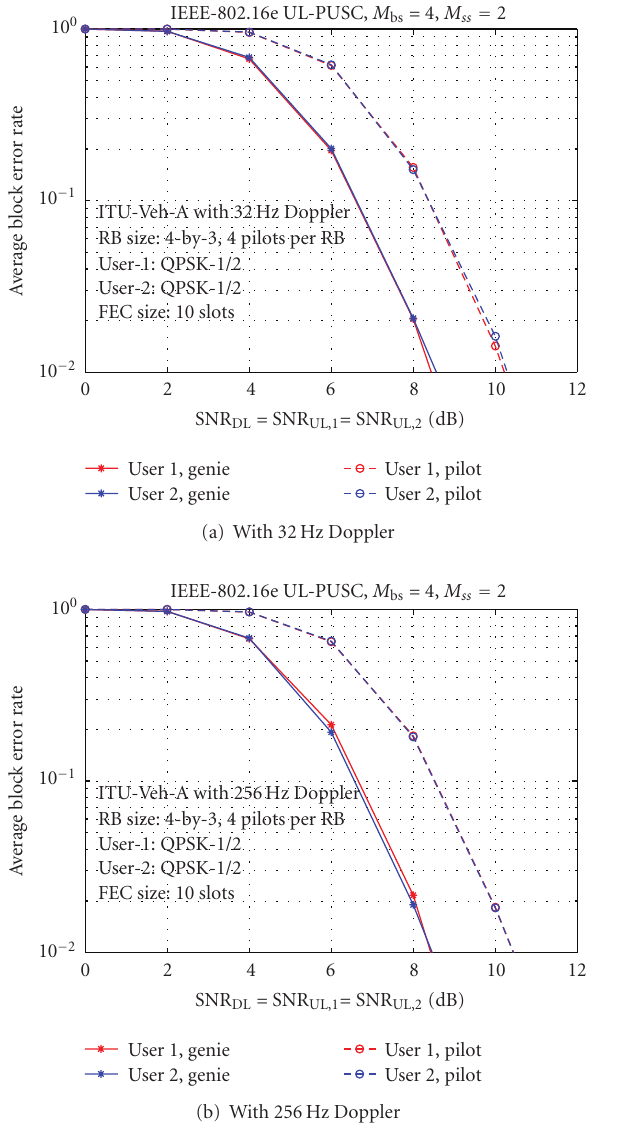
Figure 10: Performance of MMSE-BAF on MIMO-OFDMA- based IEEE 802.16e system using uplink partial utilization of subchannelization (PUSC) permutation. Each user employs rate- 1 / 2 convolutional turbo coding (CTC) with 64QAM modulation. The FEC block length is 288 information bits which corresponds to 2 slots, with 48 modulation symbols per slot, as per the terminology in